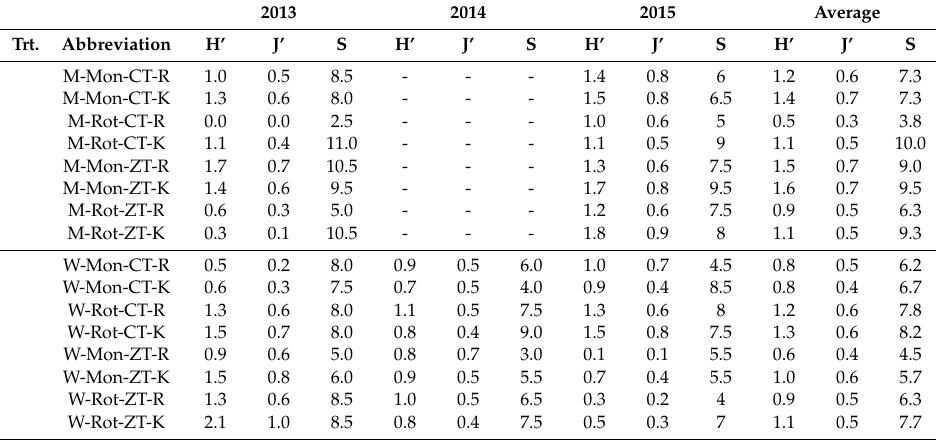
Table 6. Species diversity, species evenness and number of species determined in plots without herbicide application. Averages for 2013, 2014 (only wheat plots) and 2015. Abbreviations: H’: Species diversity; J’: evenness; S: number of species. Weeds were not sampled in maize in